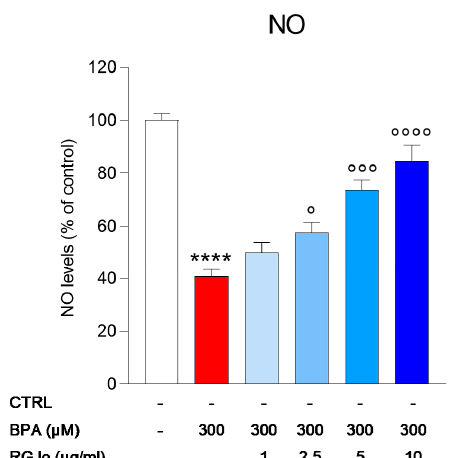
Figure 5. Effect of RGJe on reduction of NO release induced by BPA in HUVECs. The NO levels were determined by a colorimetric assay. Data are expressed as the percentage value of NO detected in treated cells compared to untreated ones and are shown as mean ± SEM from three independent experiments performed in triplicate (n = 9). **** p < 0.0001 vs. CTRL; ° p < 0.05, °°° p < 0.001, and °°°° p < 0.0001 vs. BPA 300 µM.